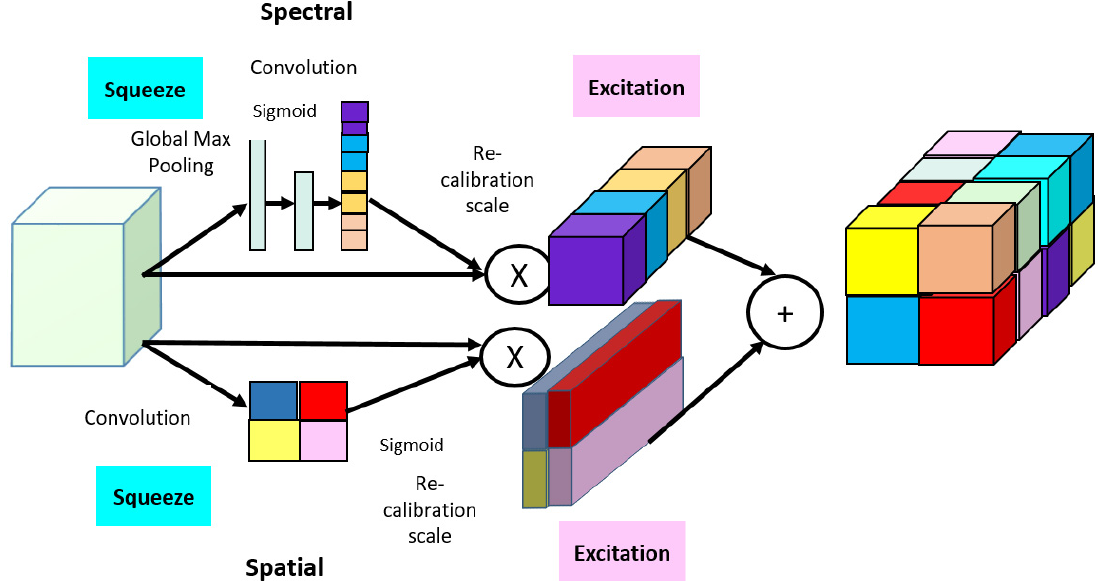
Figure 4. Spatial–spectral squeeze-and-excitation block structure.